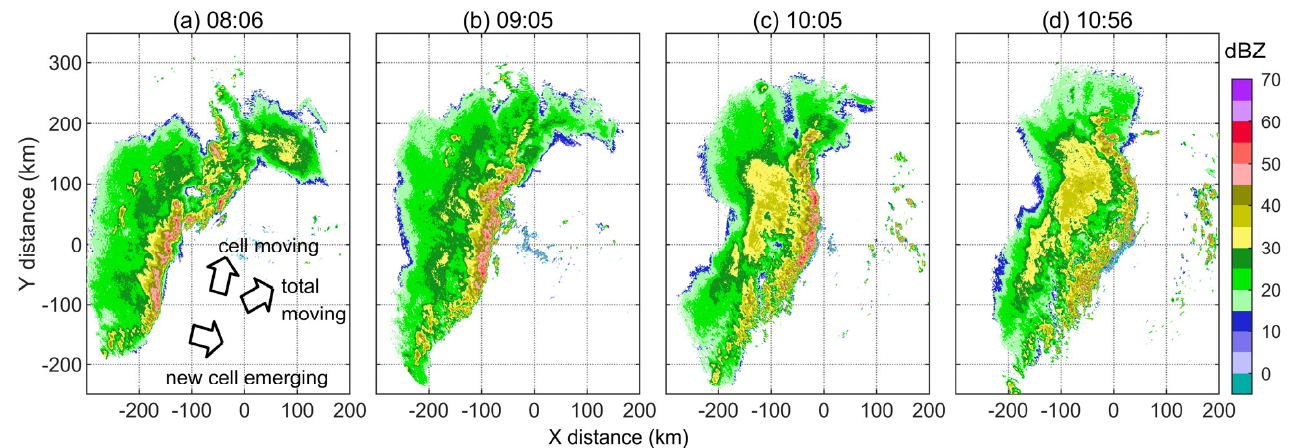
Figure 3. CAPPI at a height of 3 km observed by KTLX radar on 20 May 2011. X and Y represent west ‒ east and south ‒ north distances relative to the radar site. ( a ) 08:06; ( b ) 09:05; ( c ) 10:05; ( d ) 10:56. The time is in UTC. The black arrows in ( a ) represent the visual directions of cell movement, new cell emergence, and total movement of the whole system.